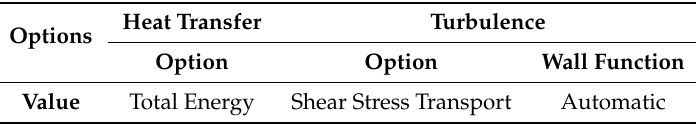
Table 6. Options in ANSYS-CFX fluid properties.